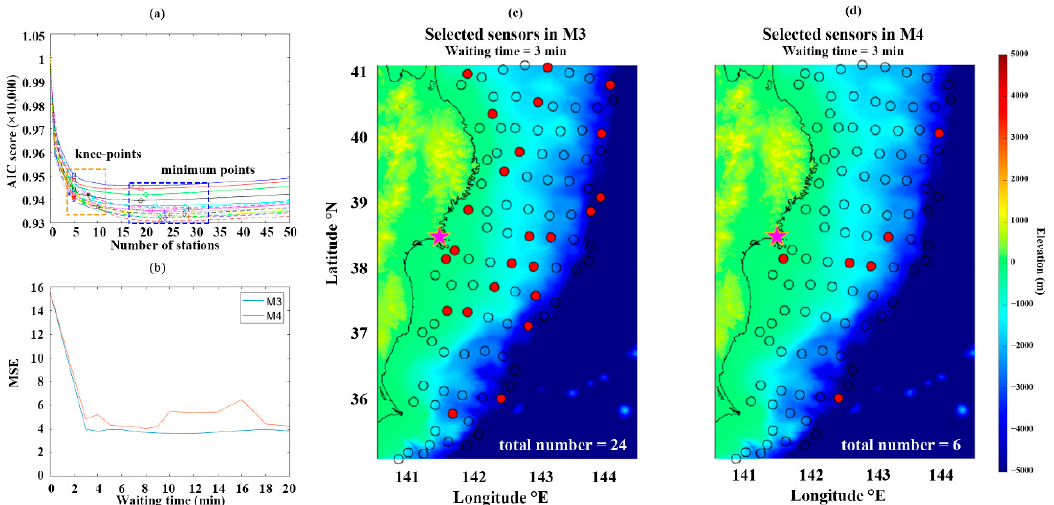
Figure 15. Results of the risk-based early warning model for Onagawa: ( a ) AIC score plot, ( b ) MSE- waiting time plot, ( c ) optimal sensor map for M3, and ( d ) optimal sensor map for M4. The pink star represents the target location (Onagawa). The red and empty circles represent the selected and unselected sensors, respectively.